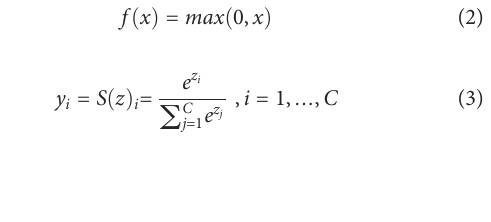
TABLE 4 TL models total